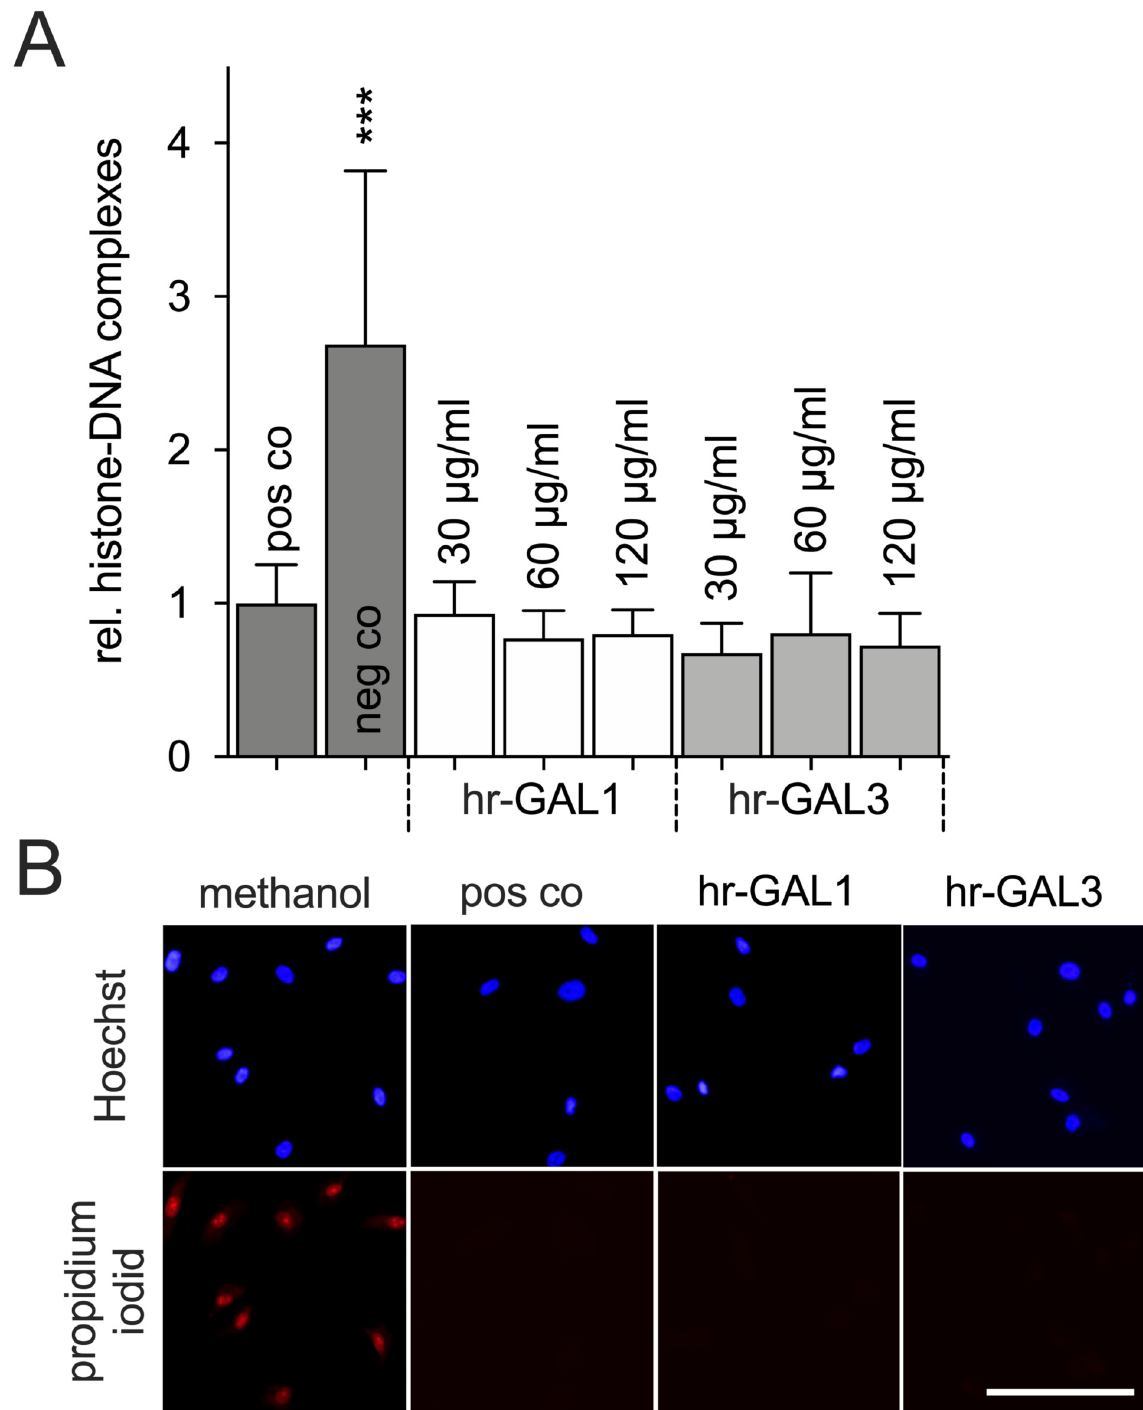
Fig 8. Hr-GAL1 and 3 have no toxic effects on HRMEC. A. Relative level of histone-DNA complexes after incubation of HRMEC in cell culture medium without (neg co) or with supplements (pos co) and hr-GAL1 or 3 for 72 h. B. Live/dead staining of HRMEC with Hoechst 33342 (blue) and propidium iodide (red) after 72 h treatment with 120 μ g/ml hr-GAL1 or 3. � pos co vs neg co; ��� p < 0.001; n = 12 of 3 independent experiments; magnification bar, 75 μ m.